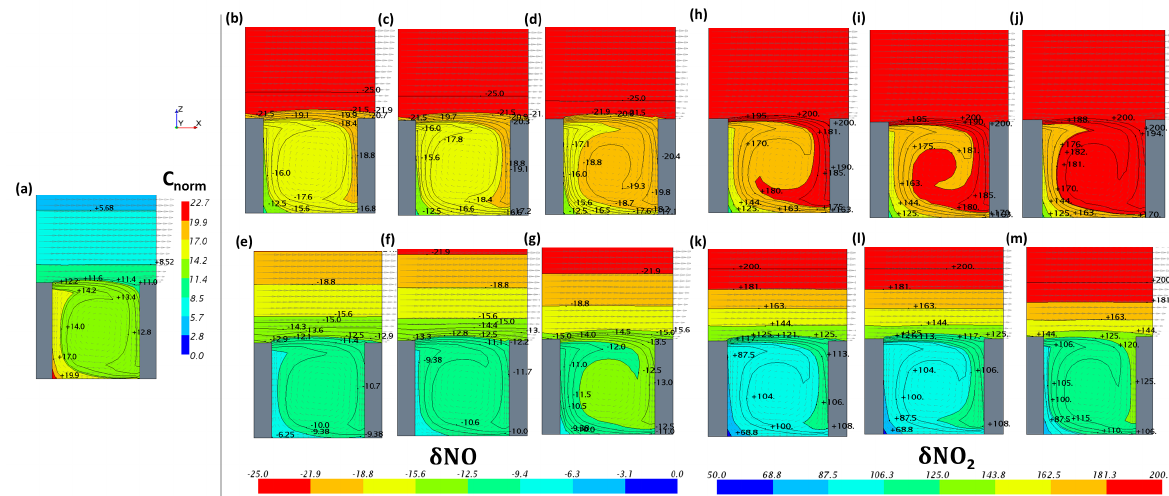
Figure 6. In the 2-D geometry: (a) distribution of normalized concentration of tracer and (b – m) the δ NO and δ NO 2 for the PSS, CCM1/5 and CCM1/2 are respectively depicted in (b – d) and (h – j) for case 1 and in (e – g) and (k – m) for case